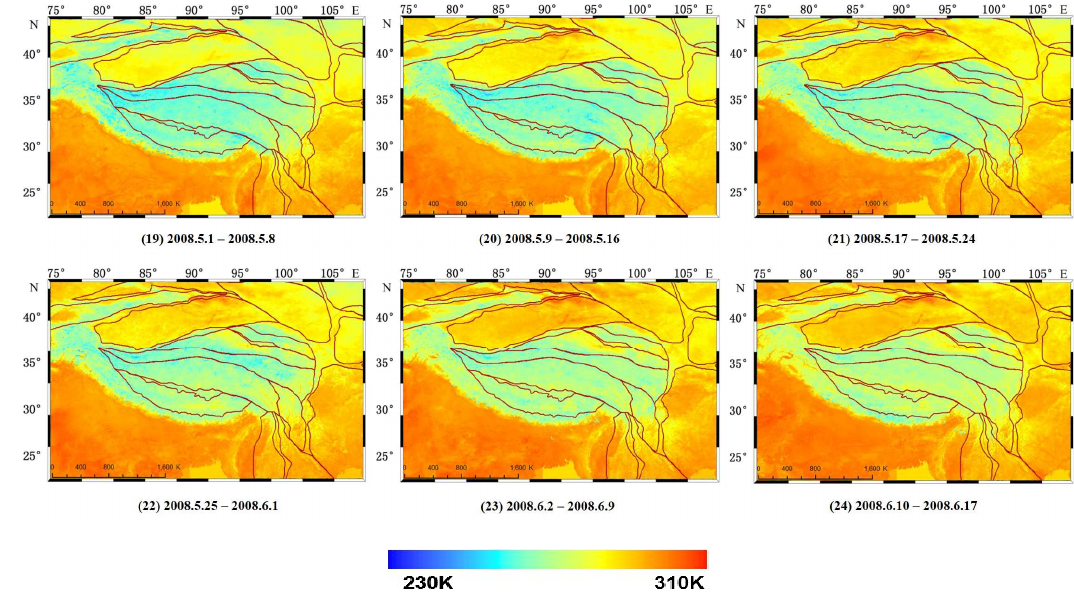
Figure 3. Original images of the MODIS LST. Table 1. Data set of the